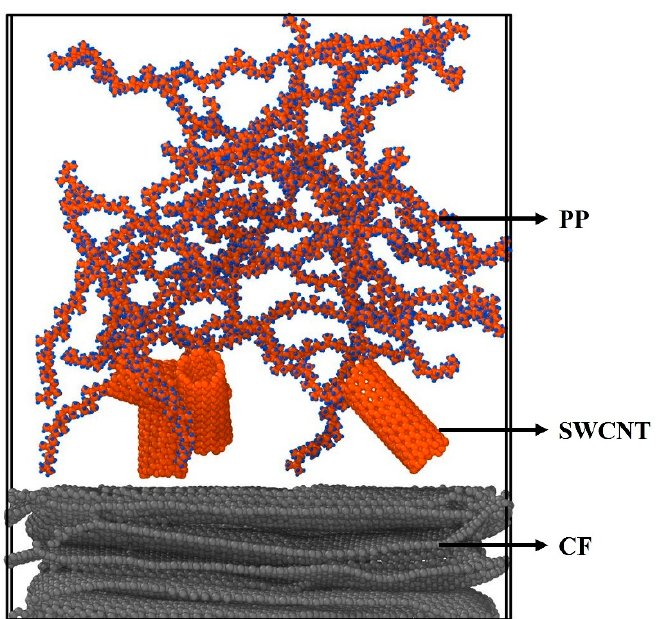
Figure 1. Nano-engineered carbon fiber composite model built with PACKMOL consisting of carbon fibers and turbostratic interconnected graphene multilayered structure with a density of 1.69 g/cm 3 coated with four (8, 6) 2.5 nm in length and 0.95 nm in diameter single-walled carbon nanotubes entangled with twenty atactic 40-monomer polypropylene chains.